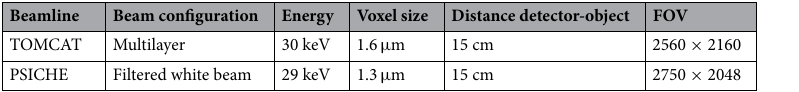
Table 1. Imaging conditions used at TOMCAT and PSICHE beam-lines (FOV corresponds to the camera size expressed in